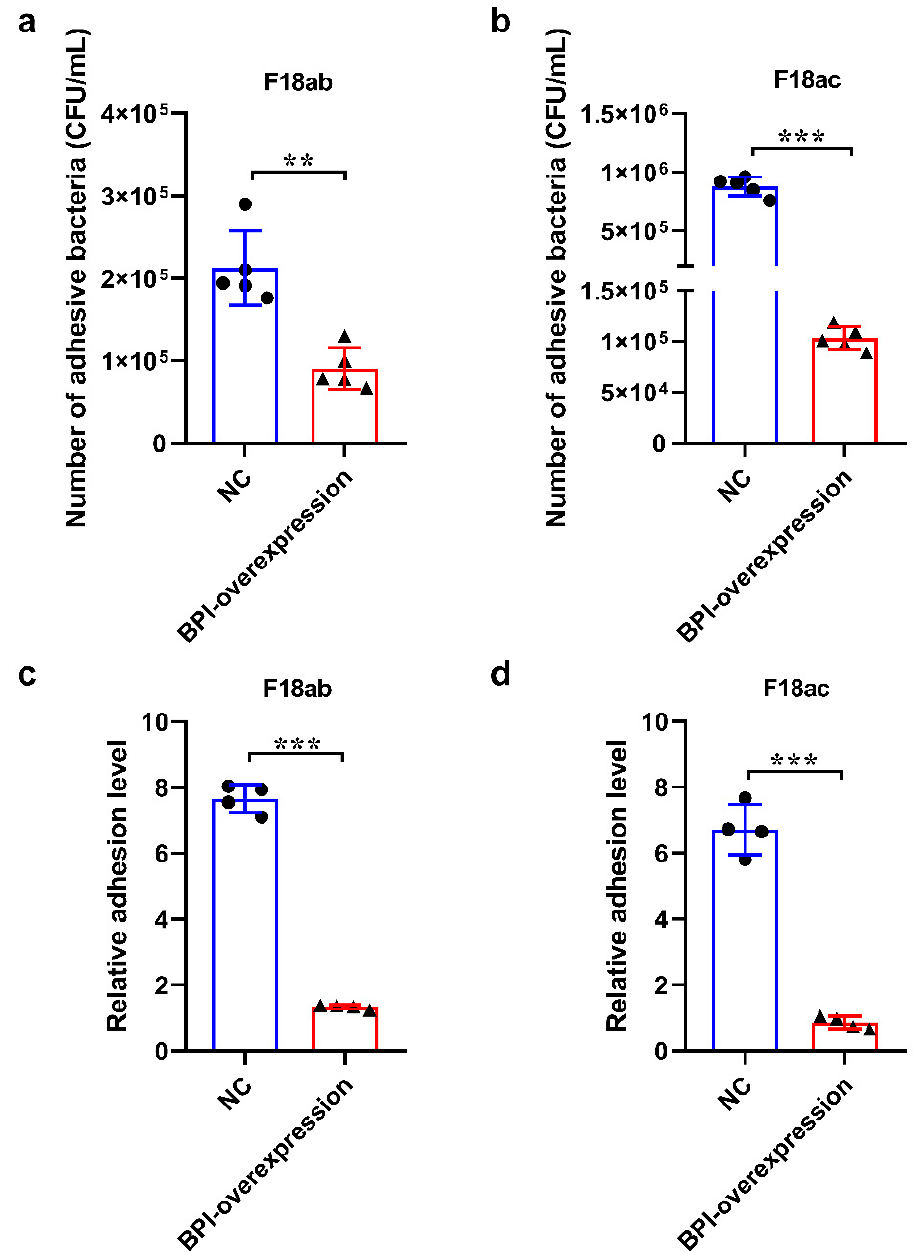
Figure 3. The impact BPI overexpression on E. coli F18 adhesion to PK15 cells in vitro. ( a , b ) E. coli F18ab and F18ac adhesion to PK15 cells was assessed via a colony counting approach ( n = 5). ( c , d ) E. coli F18ab and F18ac adhesion to PK15 cells was assessed via qPCR. NC: PK15 cells transfected with the negative control lentivirus (pGLV5-NC), BPI-overexpression: PK15 cells transfected with the BPI gene overexpression lentivirus (pGLV5-BPI). Data are means ± standard deviation. ( n = 4). ** p < 0.01, *** p < 0.001.